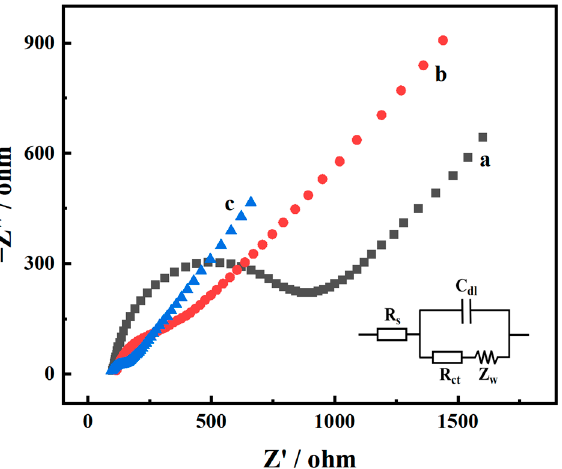
Figure 4. EIS of bare GCE ( a ), TiO 2 -Mxene ( b ), and TiO 2 -MXene/PEDOT:PSS/GCE ( c ) in 5.0 mM [Fe(CN) 6 ] 3 − /4 − solution containing 0.1 M